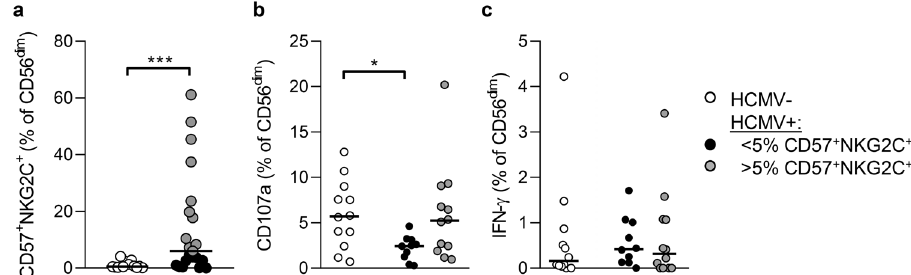
Fig. 6 Distribution of NK cell responses in HCMV seropositive individuals. Frequencies of highly differentiated NK cells (CD56 dim CD57 + NKG2C + ) in samples from HCMV seronegative ( n = 12) and HCMV seropositive ( n = 21) individuals post vaccine dose 2 in this cohort ( a ). CD107a ( b ) and IFN- γ ( c ) responses of CD56 dim NK cells HCMV seronegative (open circles) and HCMV seropositive individuals with low (<5%, black circles) and higher (>5%, grey circles) frequencies of adaptive (CD57 + NKG2C + NK cells after vaccine dose 2. Comparisons